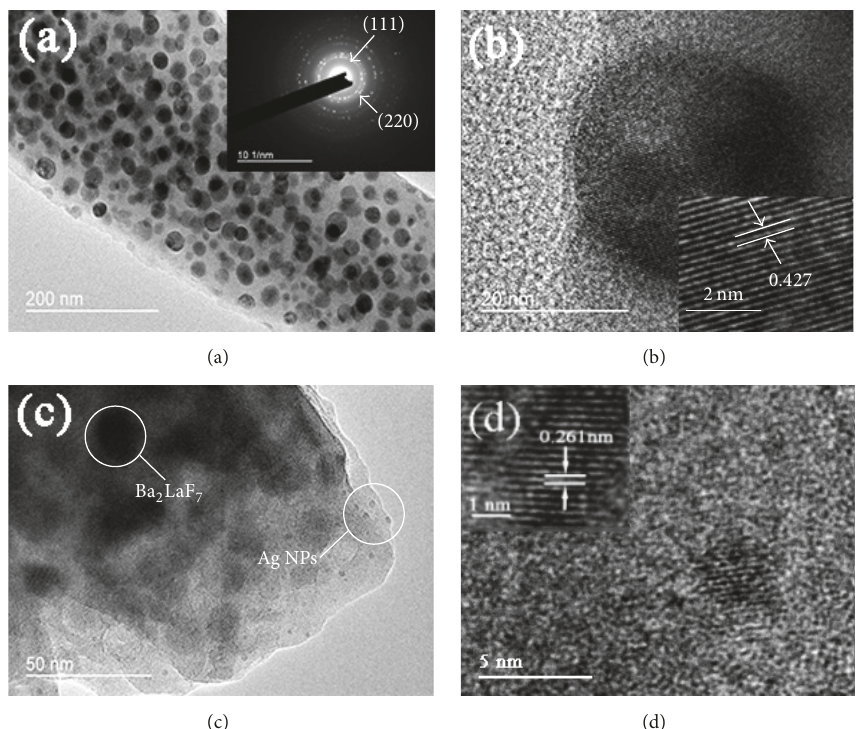
Figure 2: (a) TEM micrograph of 0 Ag sample: the inset is the SAED pattern of the 0 Ag sample. (b) HR-TEM image of 0 Ag sample: the inset is the enlargement of HR-TEM image of the corresponding sample. (c) TEM micrograph of 0.5 Ag sample. (d) HR-TEM image of 0.5 Ag sample: the inset is the enlargement of HR-TEM image of the corresponding